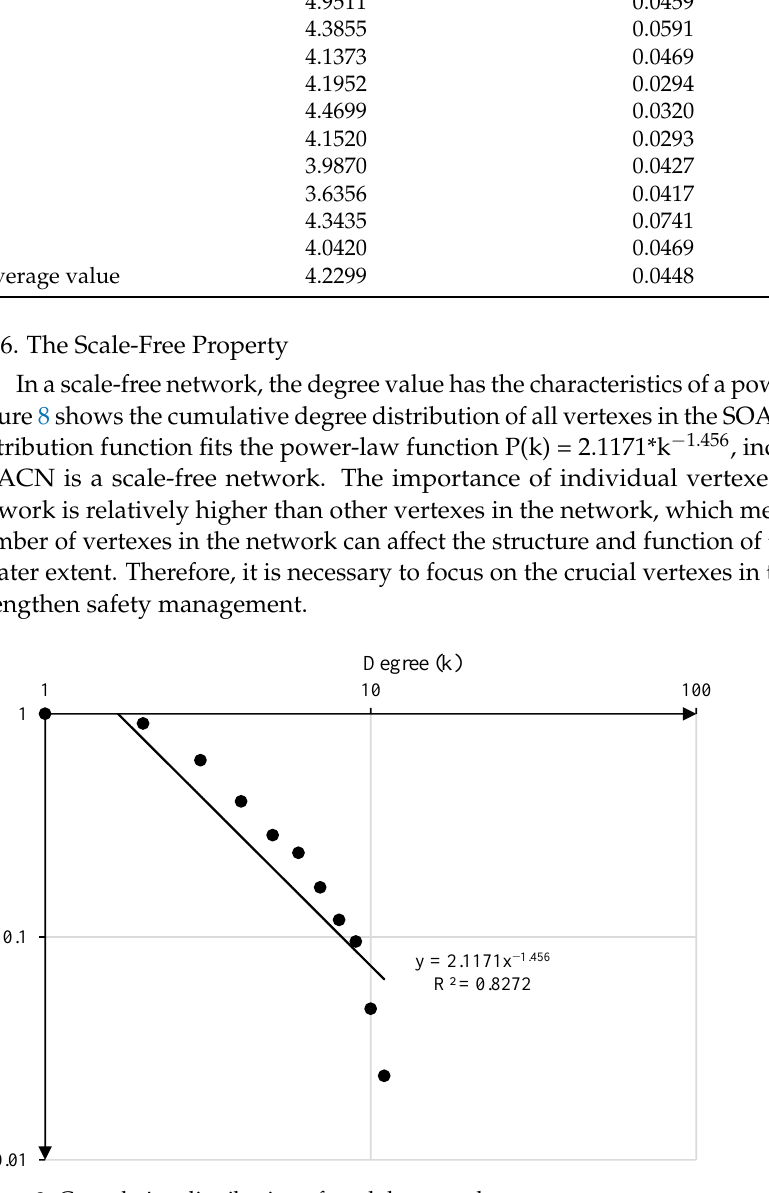
Figure 8. Cumulative distribution of total degree values.